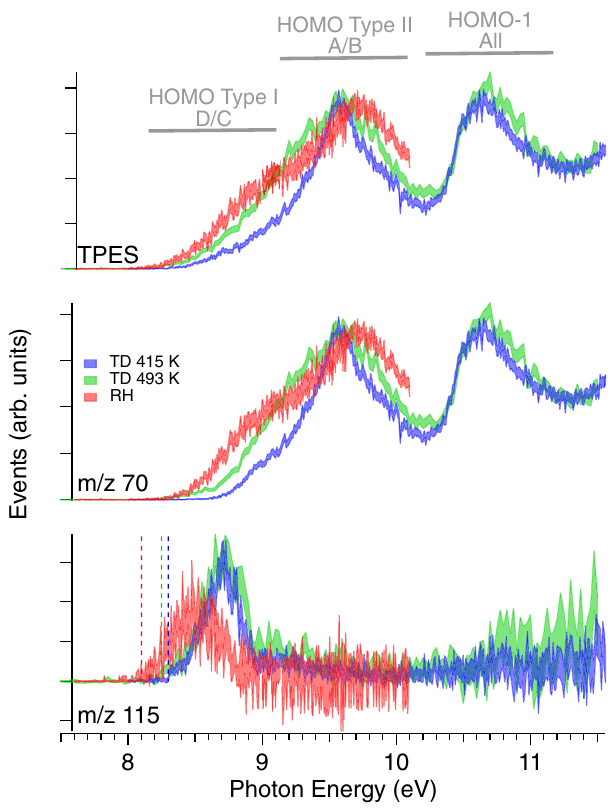
Fig. 2 TPES and TPEPICO of Pro obtained for the 3 vaporization conditions. The relative signals have been normalized according to the maximum of the TPES fi rst band centered around 9.5 eV. The shaded area correspond to the (standard deviation) error bars for acquisition time ranging from 85 s/points (TD 493 ) to 160 s/points (RH). The dashed lines in the lower panel show the estimated apparent ionization energy obtained from the m/z 115 TPEPICO curve as the fi rst point to rise above the baseline. While the upper panel shows the full TPES, obtained by recording all threshold electrons — those having approximately zero kinetic energy such that all photon energy in excess of the ionization limit is deposited as internal excitation of the cation — the lower panels only show those threshold electrons that are found by TPEPICO coincidence detection to be accompanied by production of either parent or fragment ions. Clear temperature effects are observed on the shape and onsets (see text) of these mass-selected TPES.